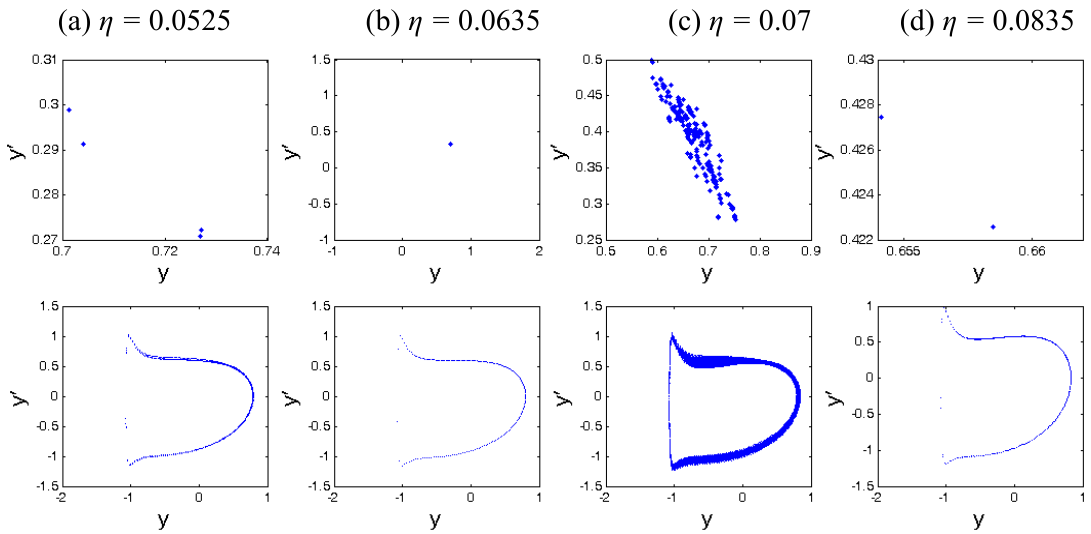
Figure 10. The Poincaré maps and phase portraits of different squeeze film damping ratios η